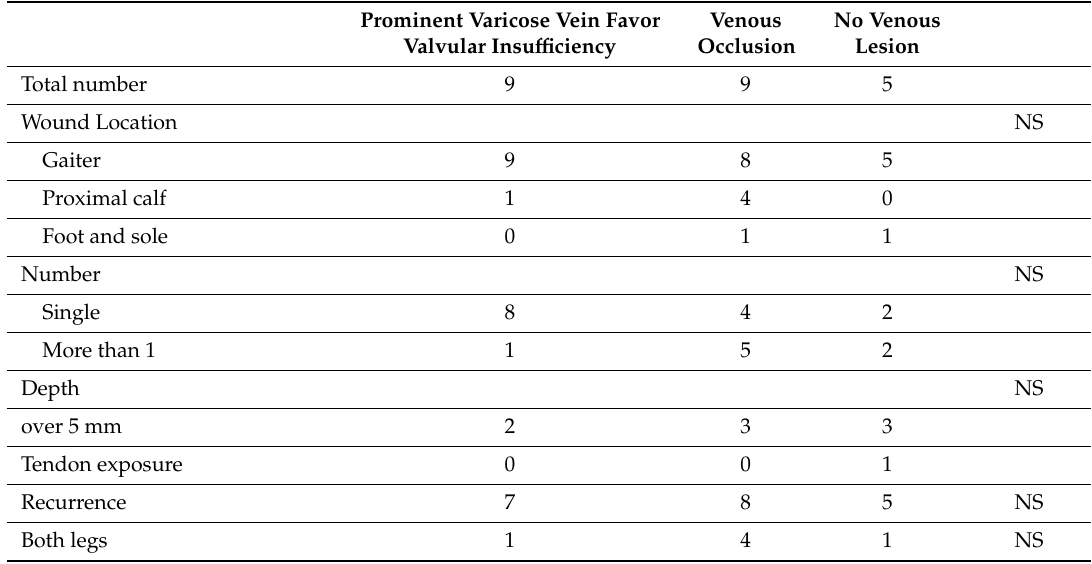
Table 3. Static leg ulcers: wound status group by TRANCE-MRI